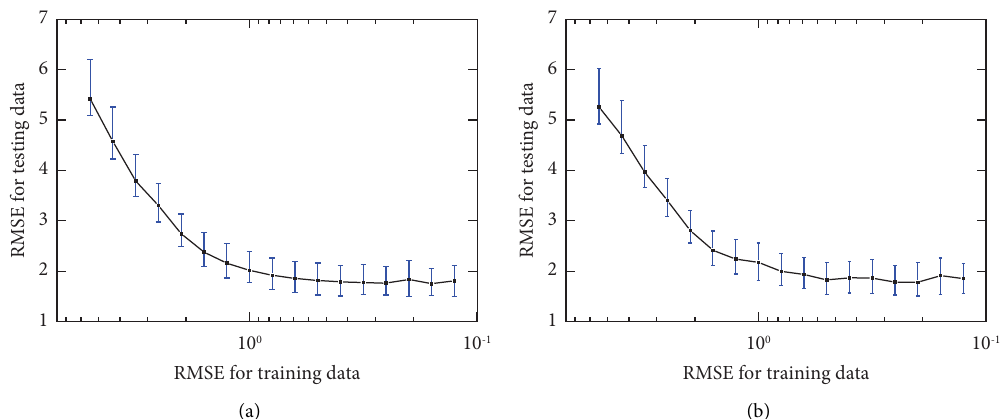
Figure 10: Testing RMSE versus training RMSE with error bar by prediction models based on LSTM. (a) Hidden node number � 10. (b) Hidden node number � 20.